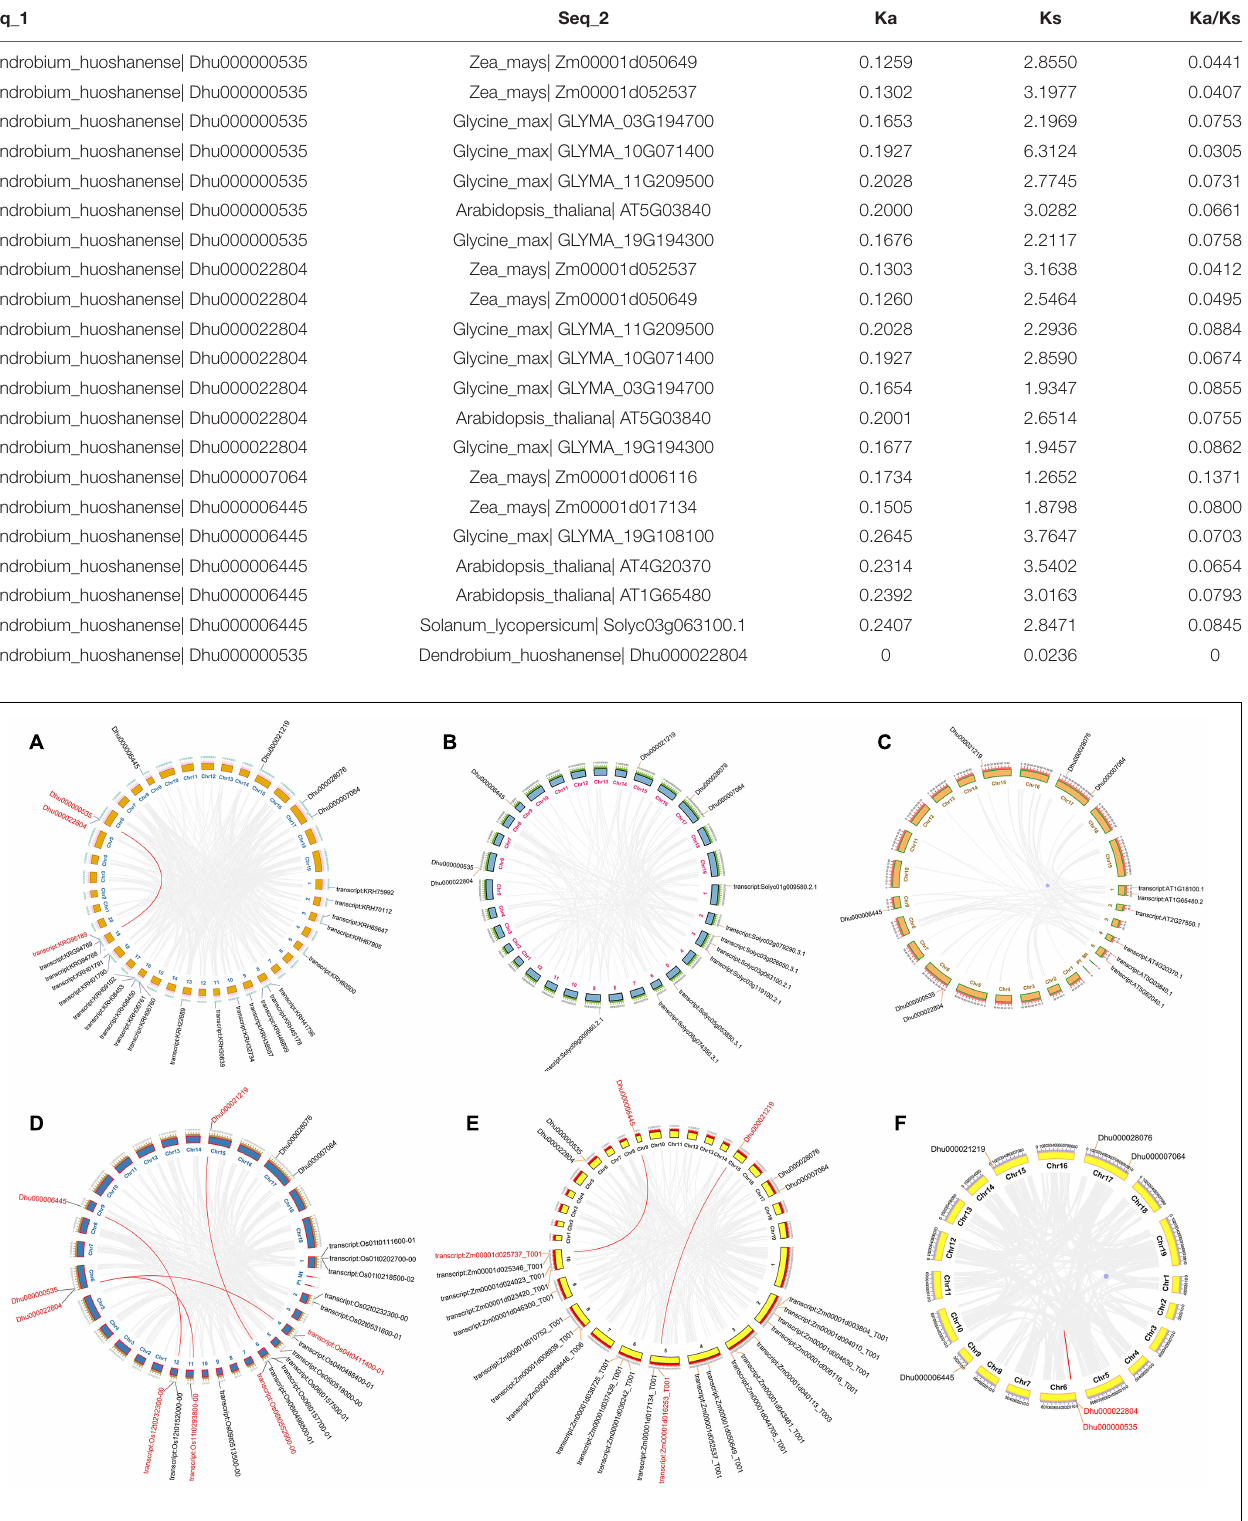
TABLE 1 | The orthologous and paralogous genes with Ka/Ks ratio among five species. Seq_1